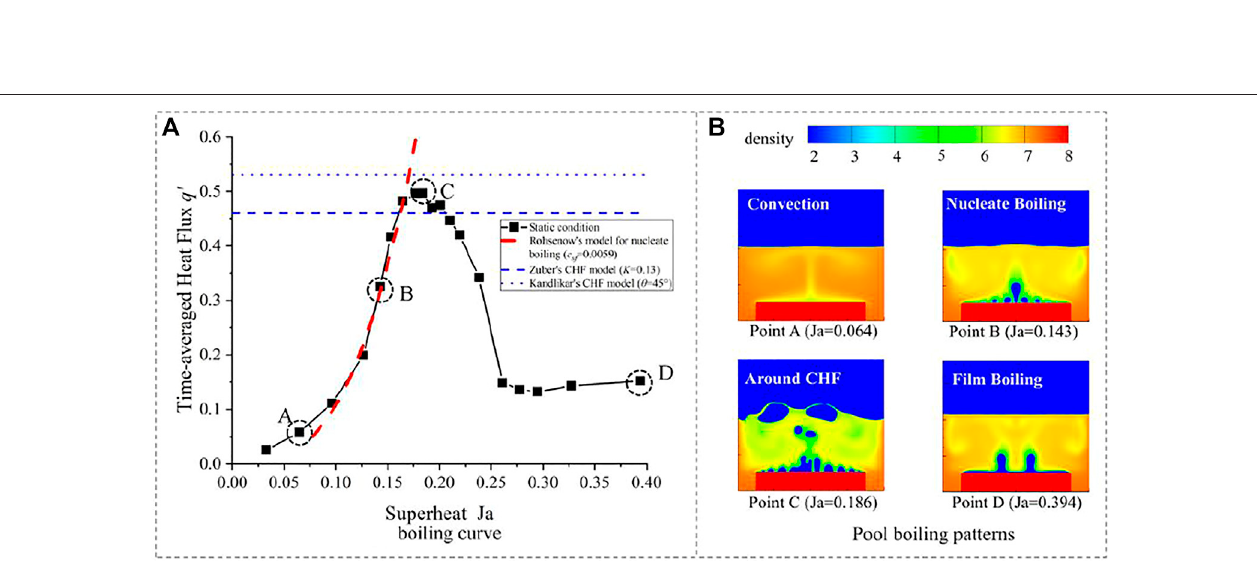
FIGURE 5 | (A) Pool boiling curve under static conditions validated with recognized empirical equations. (B) Pool boiling patterns with typical bubbles ’ evolution.